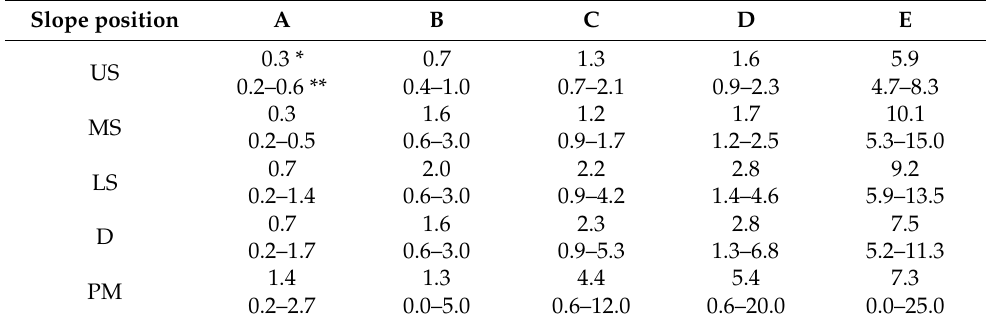
Table 8. Granulometric indices in humus horizons and parent materials in ice-dammed lakes land- scape, regarding the soil position at the